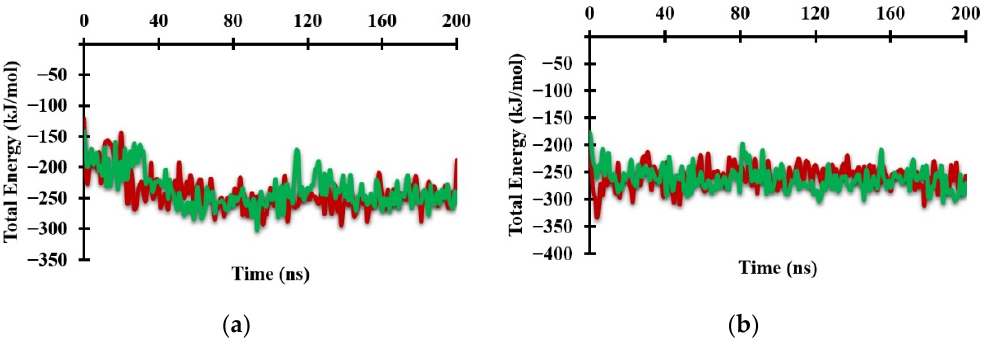
Figure 5. Graph of the total system energy from MM/PBSA calculations when ( a ) Antagonist-REV-ERB β and ( b ) Agonist- REV-ERB β form complexes with Heme (green) and CoPP (red) during molecular dynamic